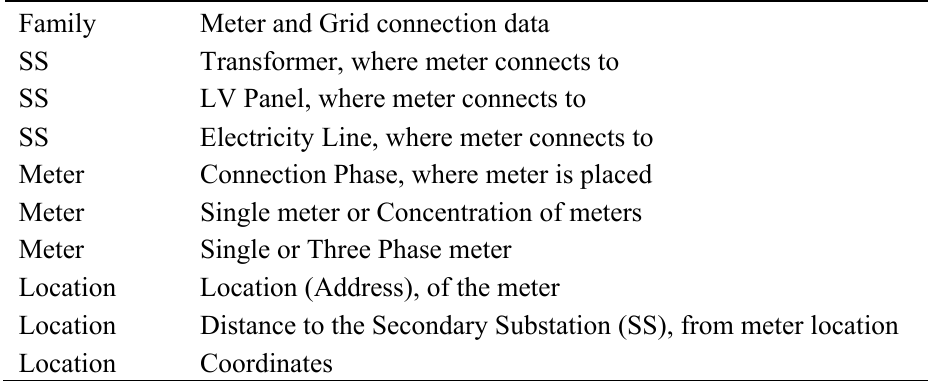
Table 2. Meter and electricity grid related data for PLC